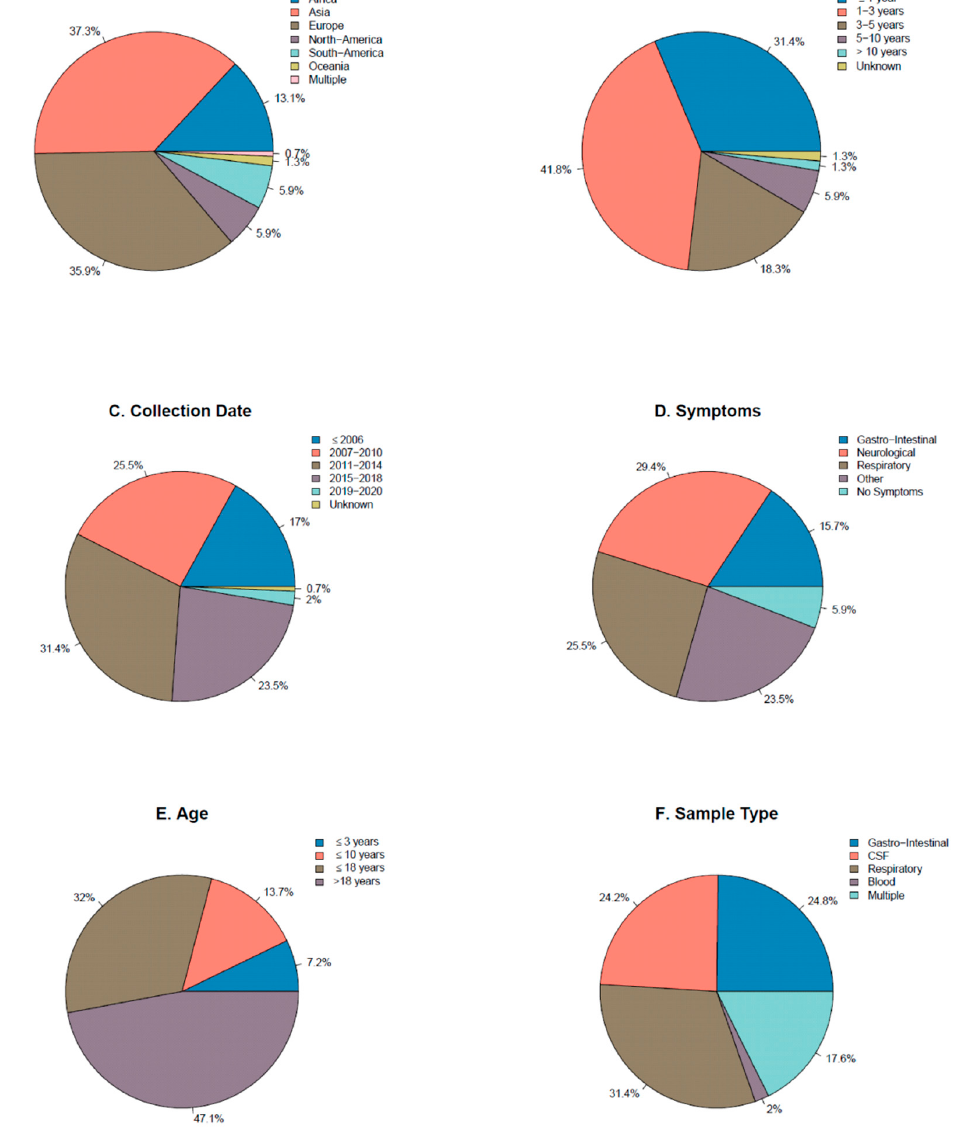
Figure 2. Pie charts showing the characteristics of the included studies; ( A ) Continent where the study was conducted ( B ) Duration of the inclusion period ( C ) Year in which the final inclusion/sample collection took place ( D ) The sample type collected ( E ) The symptoms of the included study participants ( F ) The age of the included participants. The ‘>18’ category includes studies in both children and adults and in exclusively adults. CSF; cerebrospinal fluid.